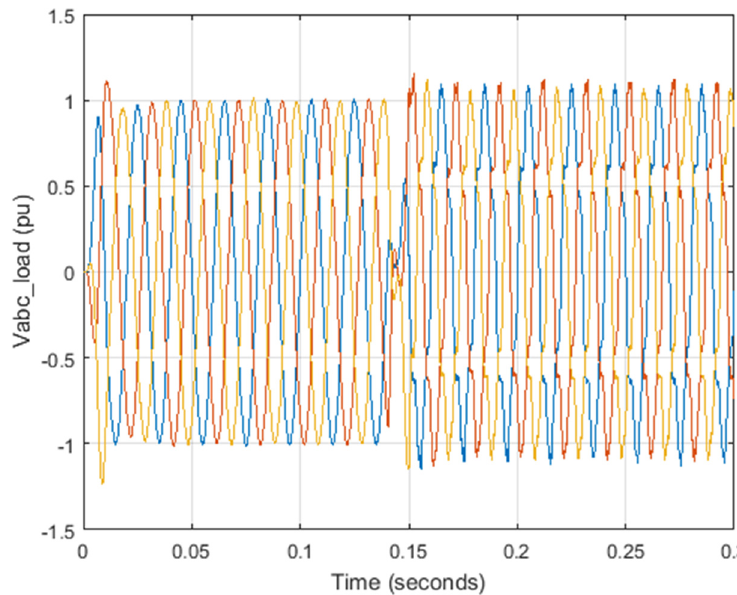
Figure 25. Load voltage.